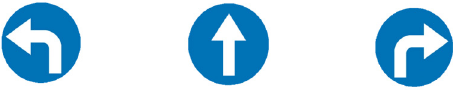
Fig. 3. Navigation message in the form of arrows similar to road signs